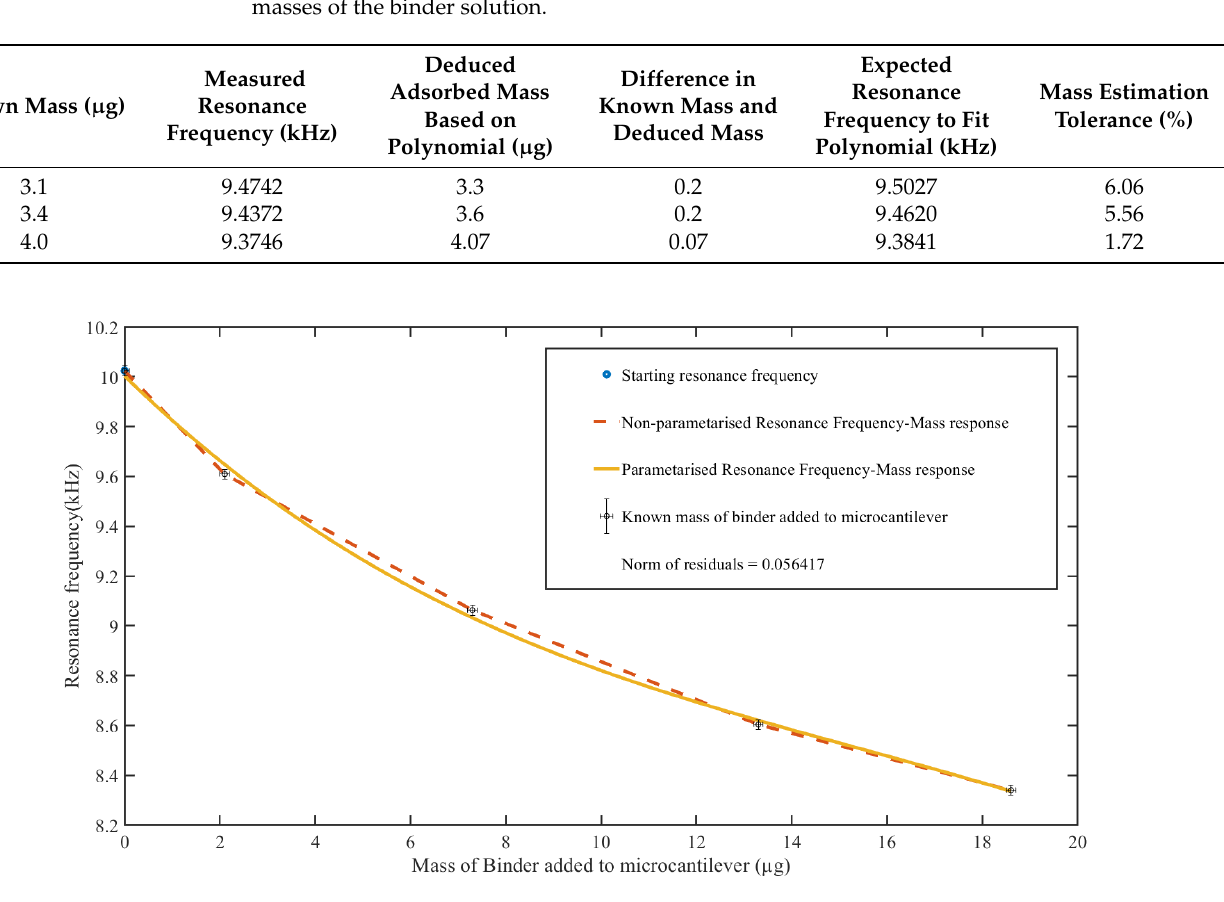
Figure 8. Calibration set-2 resonance frequency response to the added mass response of the micro- cantilever characterized into a polynomial (solid